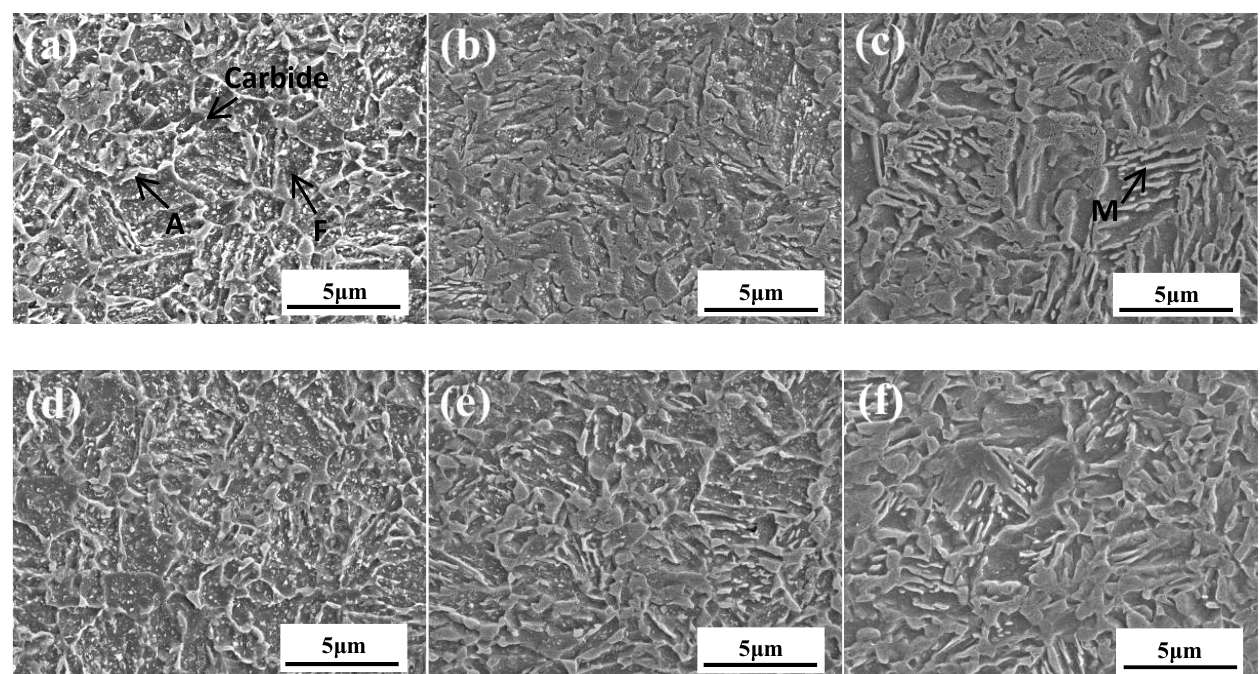
Figure 3. Microstructure of two groups of experimental steels at different annealing temperatures: ( a , d ) 625 °C, ( b , e ) 645 °C, ( c , f ) 665 °C; ( a – c ) 0 RE, ( d – f ) 9 ppm RE.